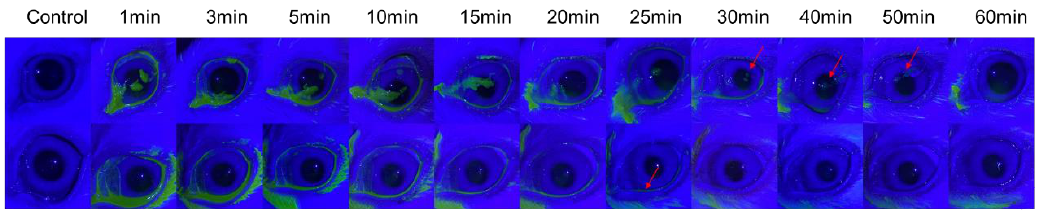
Figure 6. In vivo fluorescence imaging of Fls-gel and Fls-solu at various time points after instilla- tion.